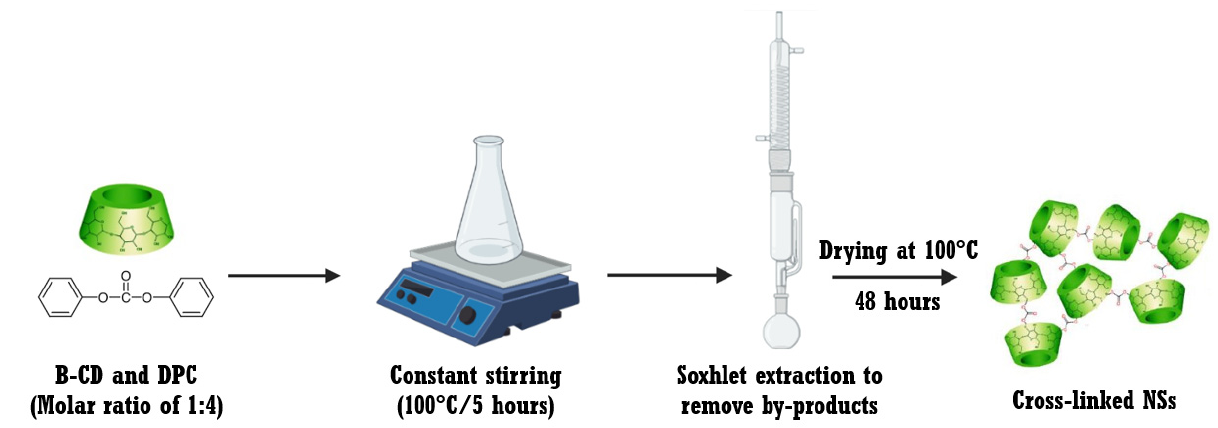
Figure 2. Schematic representation of the synthetic route of NSs .